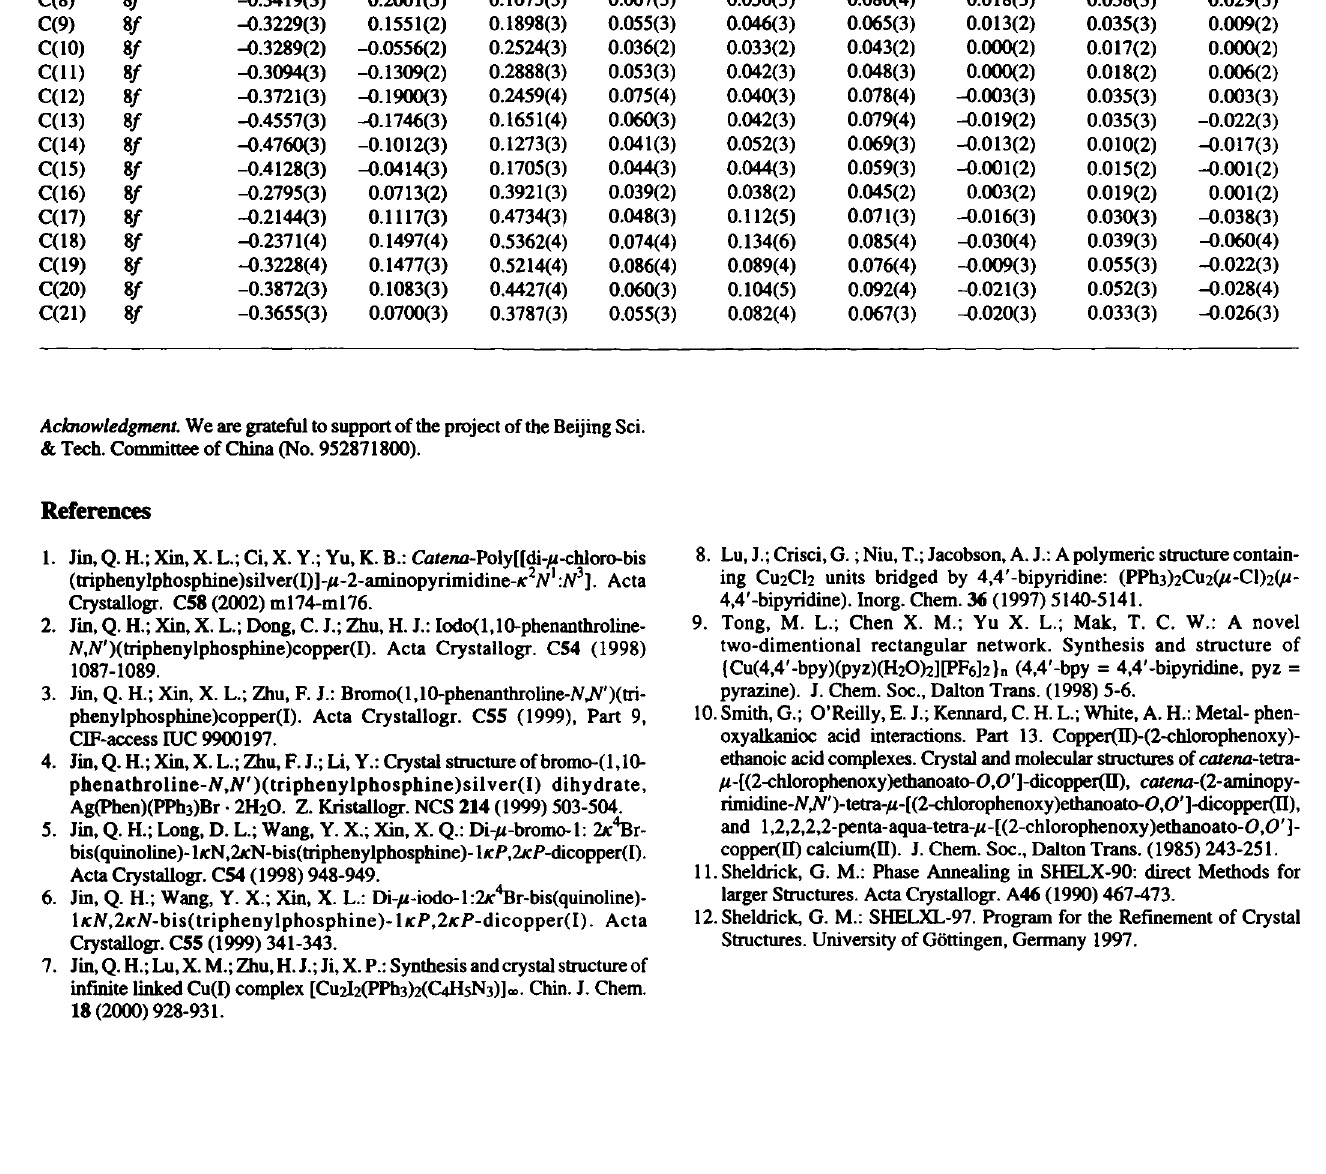
Table 3. Atomic coordinates and displacement parameters (in Â 2